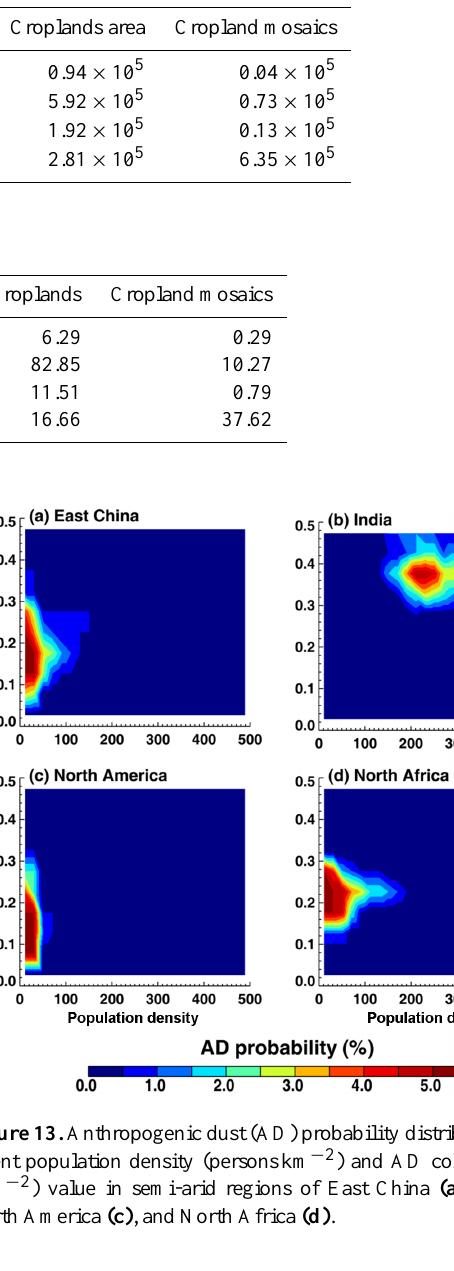
Table 3. Different land cover areas (km 2 ) .